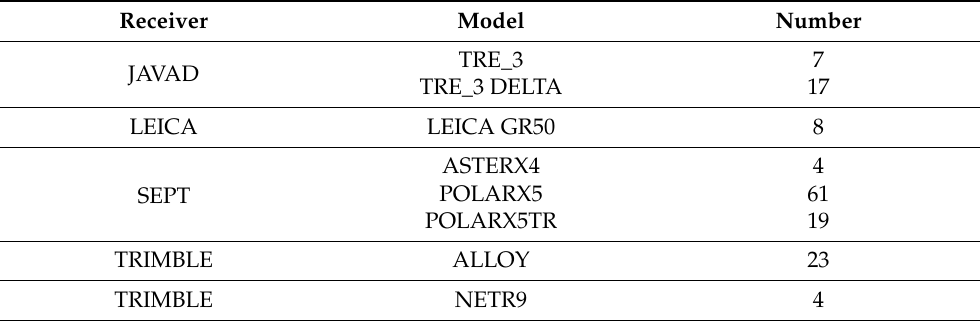
Table 4. Type and number of receivers.